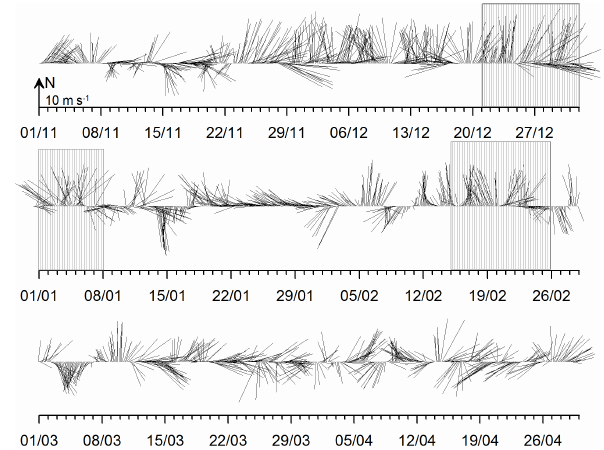
Figure 2. Time series of the 10-m level Tallinnamadal wind vector from 1 November 2011 to 30 2 April 2012. Shaded areas mark time intervals when estuarine circulation reversals prevailed. 3 Fig. 2. Time series of the 10m level Tallinnamadal wind vector from 1 November 2011 to 30 April 2012. Shaded areas mark time inter- vals when estuarine circulation reversals